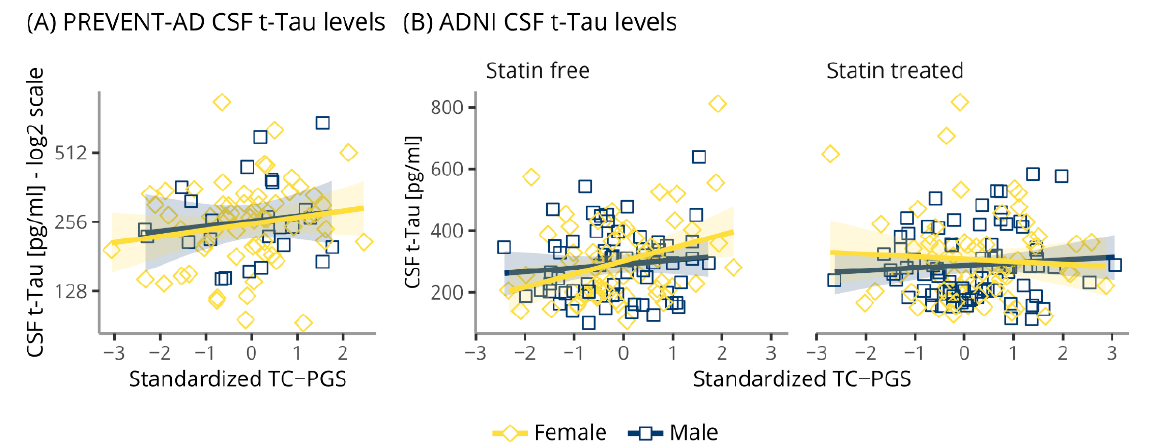
Figure 5. Associations of TC-PGS with biomarkers of neurodegeneration. Biomarkers of neurodegeneration as assessed by CSF levels of t-Tau plotted against TC-PGS. Data was analyzed by multiple linear regressions. ( A ) PREVENT-AD CSF levels of t-Tau. ( B ) ADNI CSF t-Tau levels. Shaded areas indicate 95% confidence intervals. Abbreviations: CSF, cerebrospinal fluid; t-Tau, total TAU; TC-PGS, total cholesterol polygenic